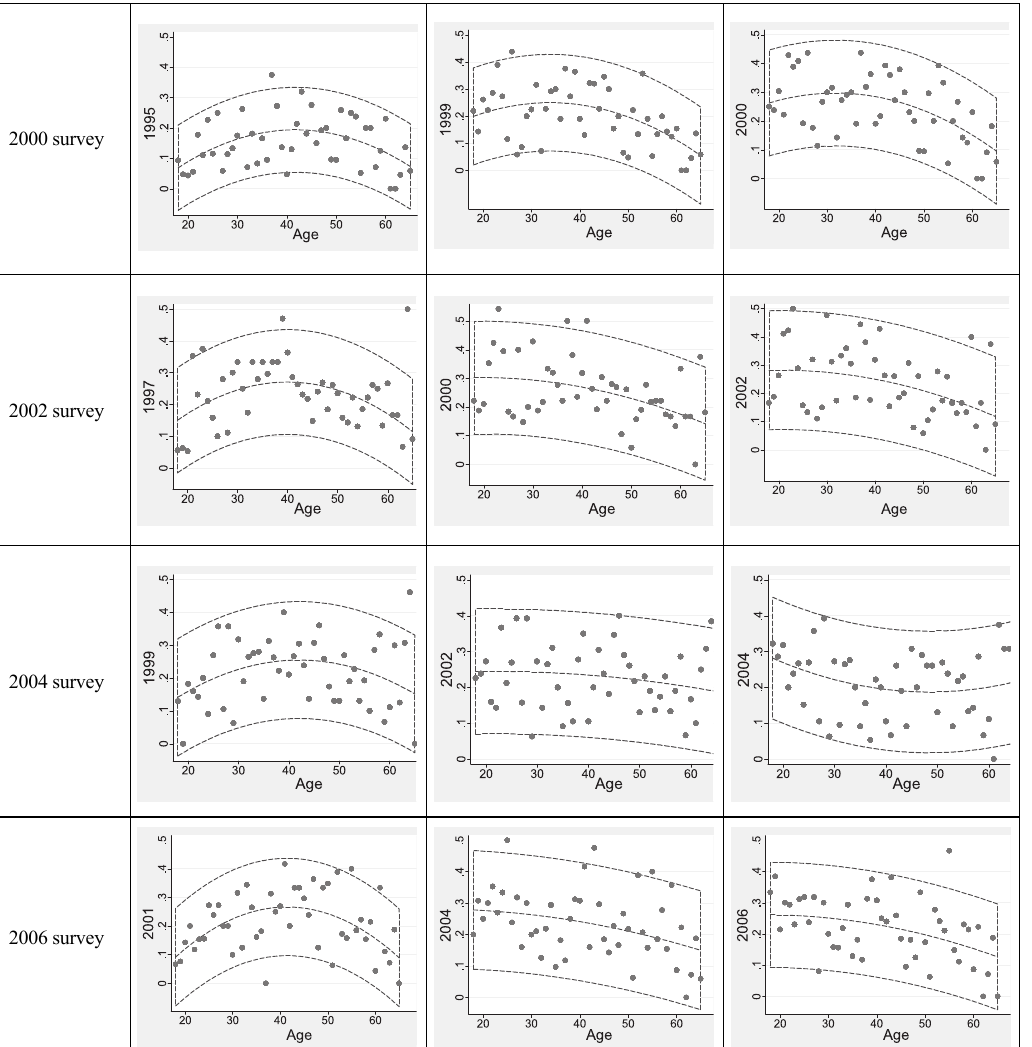
Figure 3 : Evasion Rates by Age Groups for All Four